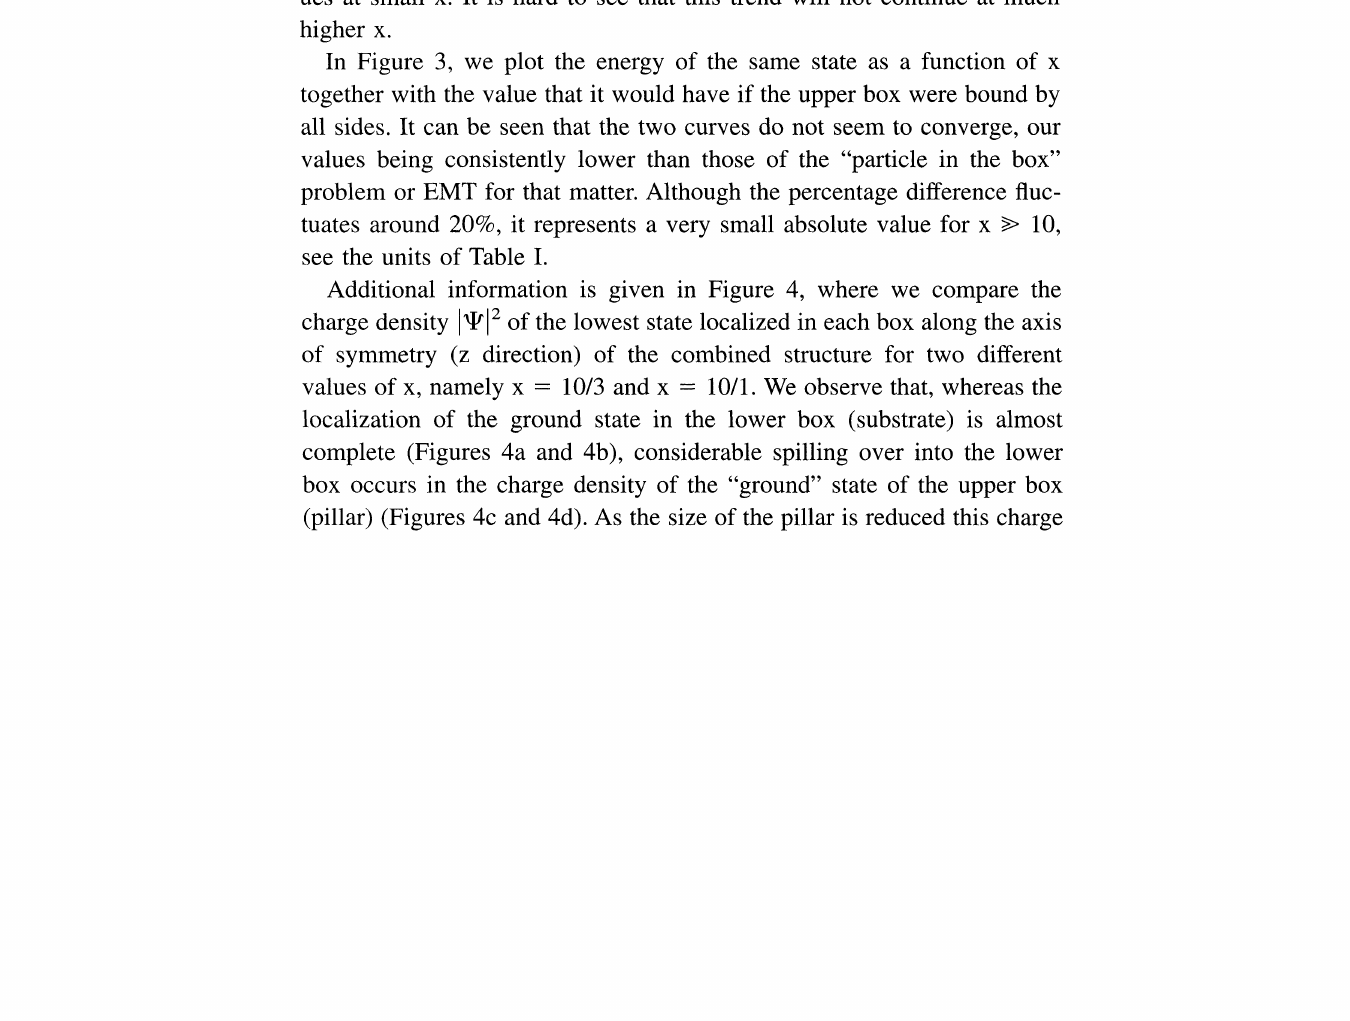
FIGURE 2 Variation of the localization factor (A/B) w.r.t x Dn/D